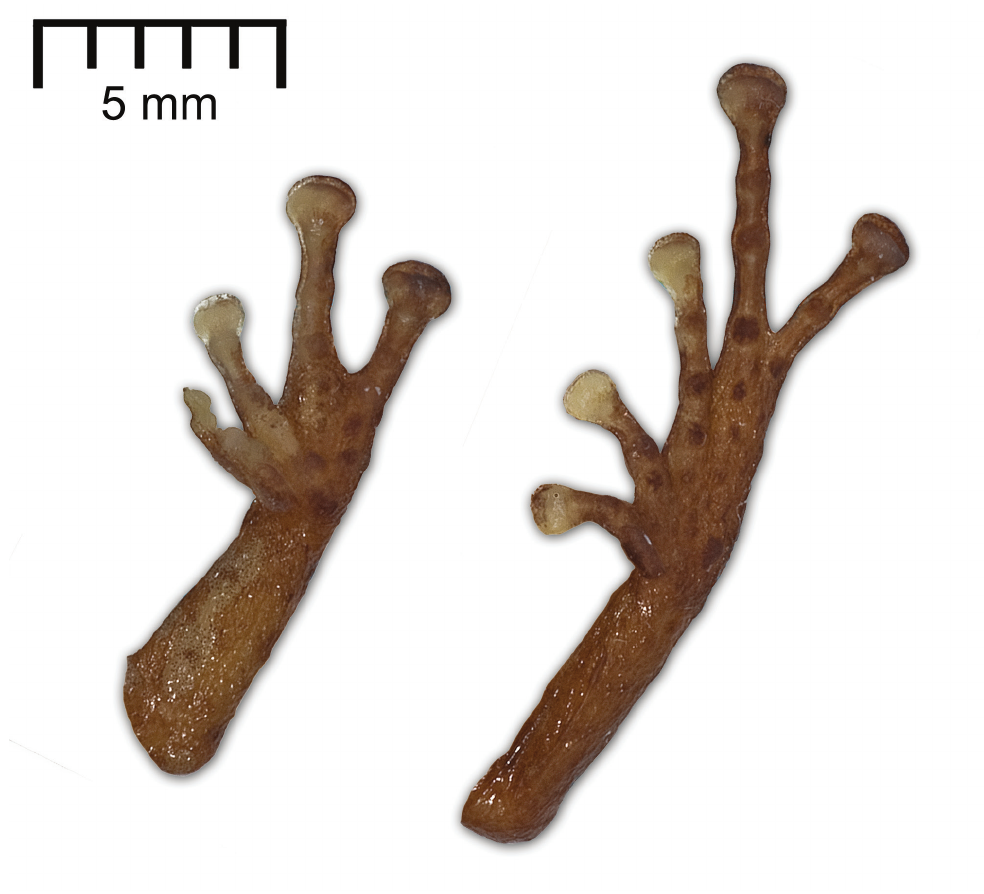
Fig. 3. Pristimantis jamescameroni sp. nov. Ventral view of left hand and left foot of the ♂ holotype (IRSNB 4160). Photographs by the